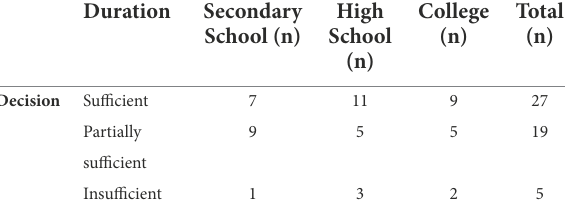
TABLE 1 Opinions on the duration of socio-cultural trips.